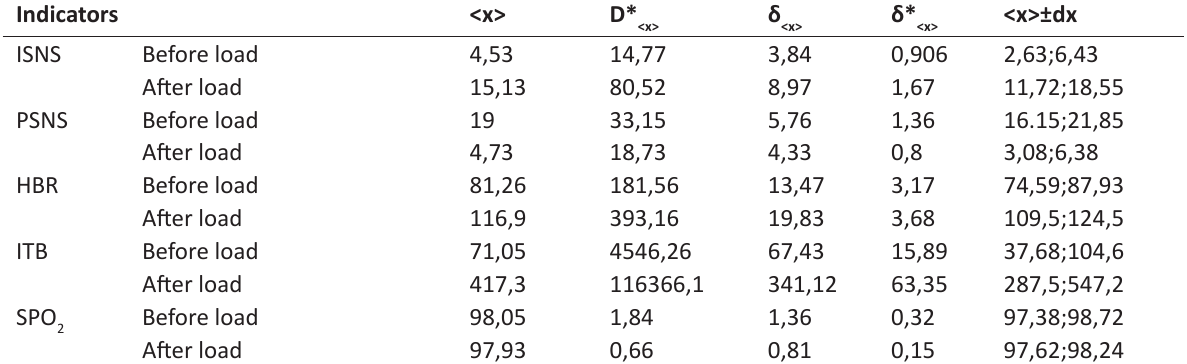
Table 2. Cardio-respiratory indicators of 1 st group boys’ functional system before and after physical load до і після фізичного навантаження